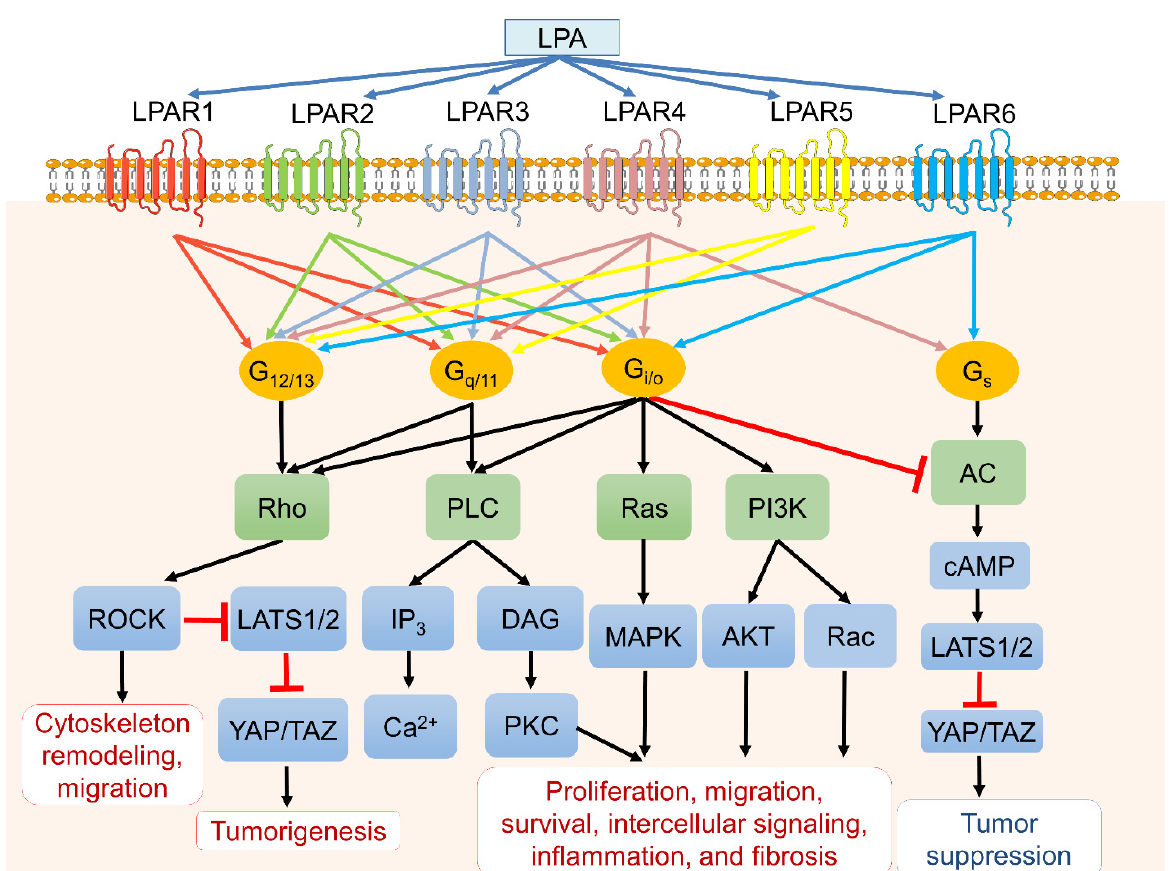
Figure 2. LPA, LPA receptors (LPARs), and downstream signaling pathways. LPA binds six primary LPA transmembrane receptors (LPAR1 to LPAR6) with varying affinities that couple to four different heterotrimeric G proteins (G 12/13 , G q/11 , G i/o , and G s ) and trigger various downstream signaling cascades. LPA subsequently mediates cellular events such as cell proliferation, survival, apoptosis, migration, cytoskeleton reorganization, fibrosis, and inflammation.